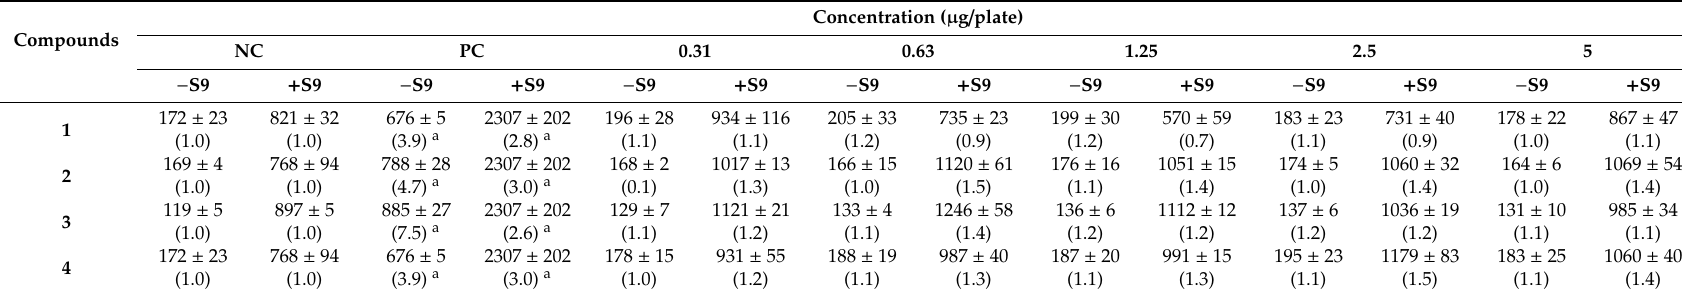
Table 3. The number of revertant colonies of TA100 strain of Salmonella typhimurium in the absence ( − S9) and presence ( + S9) of metabolic activation system.